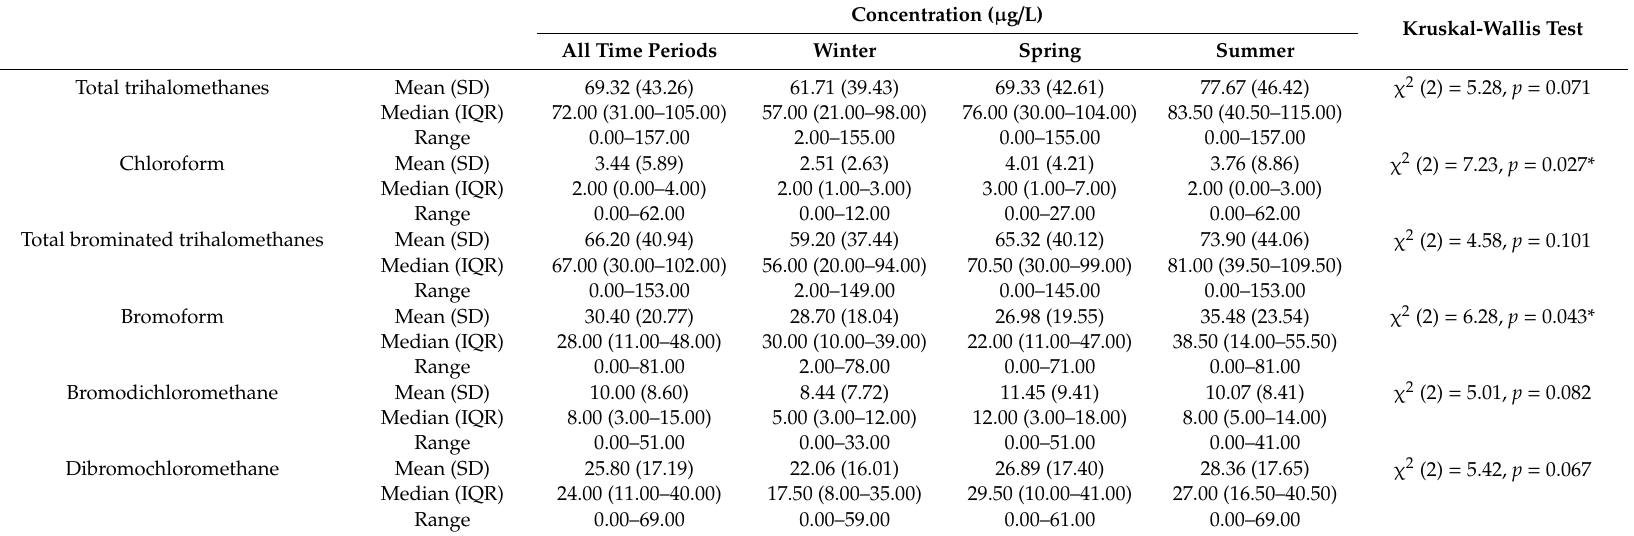
Table 2. Summary of the concentrations ( µ g / L) of total trihalomethanes, total brominated trihalomethanes, and the four species of trihalomethanes across all sampling periods together, and winter, spring, and